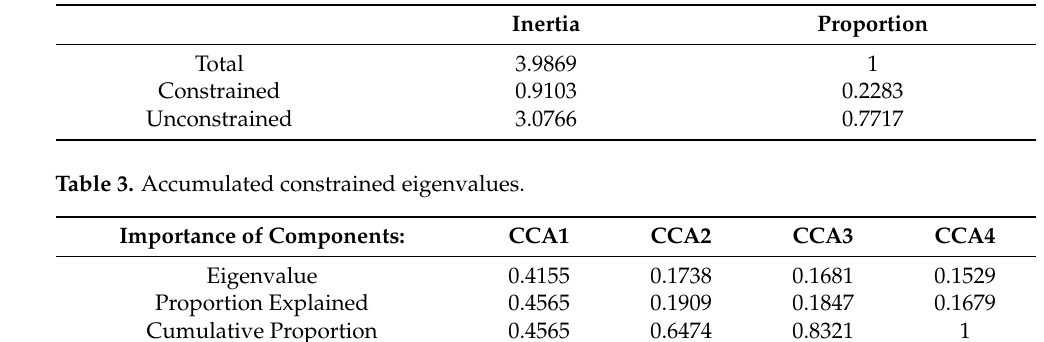
Table 2. Proportion of inertia explained by constrained and unconstrained ordination.